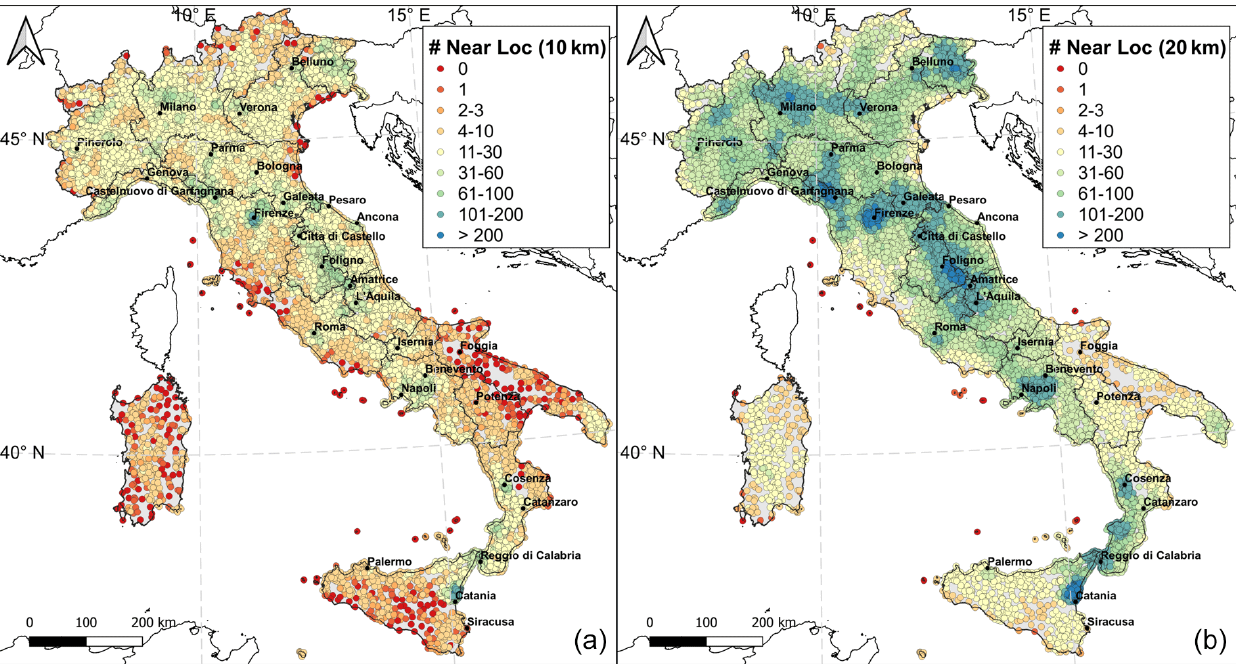
Figure 1. Number of neighboring localities within 10km (a) and 20km (b) for all the Italian localities in DBMI15. The 28 sites selected for testing (Sect. 4.2) are shown.